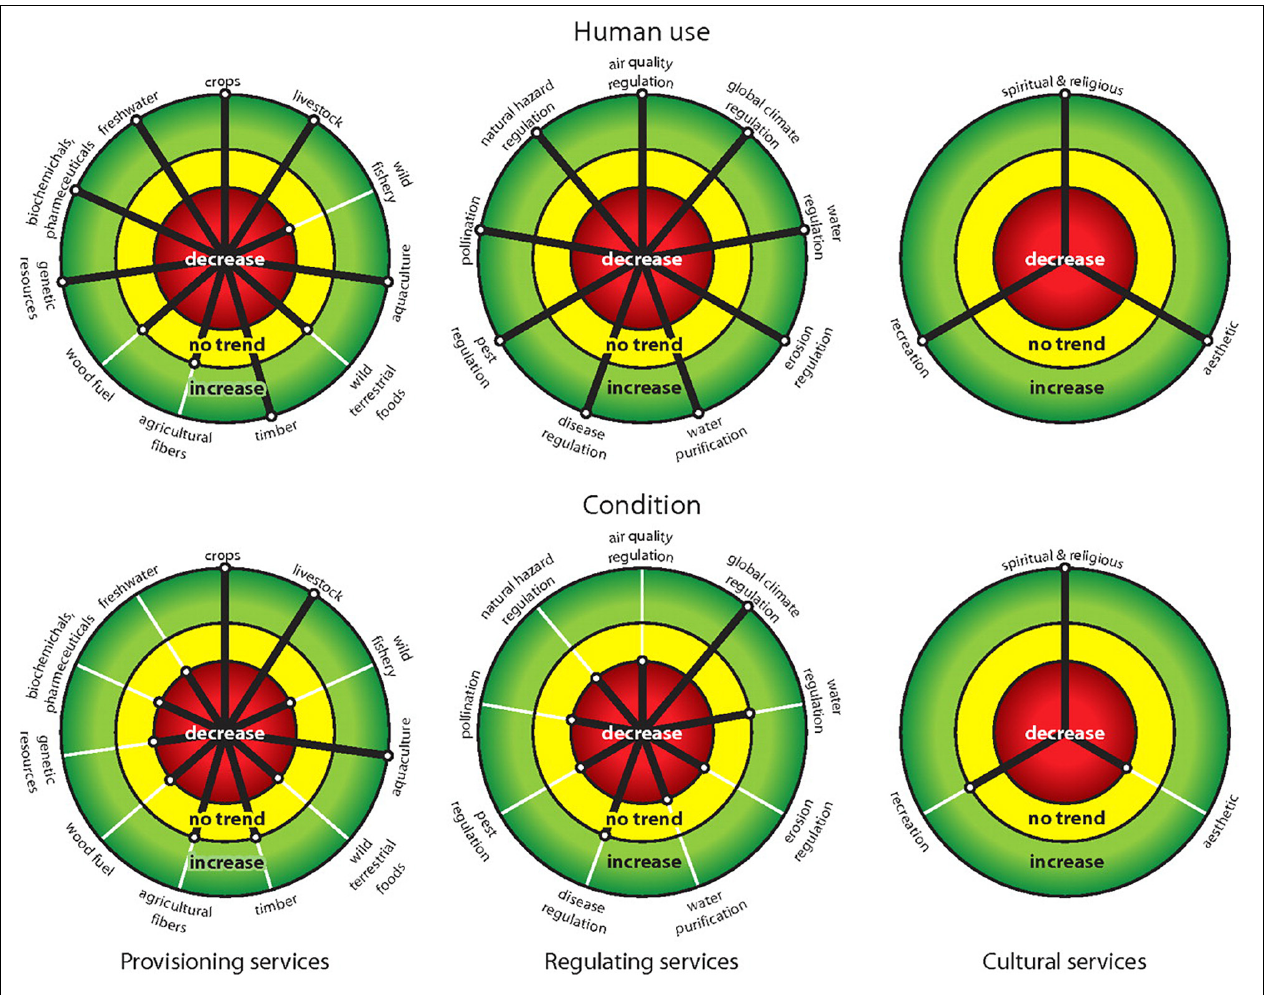
FIGURE 5 | Trends in human use (upper) and condition of ES (lower). Provisioning, regulating, and cultural ecosystem services are shown in the left, center, and right side, respectively. Length of black radial lines shows the degree of change in human use or condition of the service. Reproduced from Carpenter et al. (2009). Copyright (2009) National Academy of